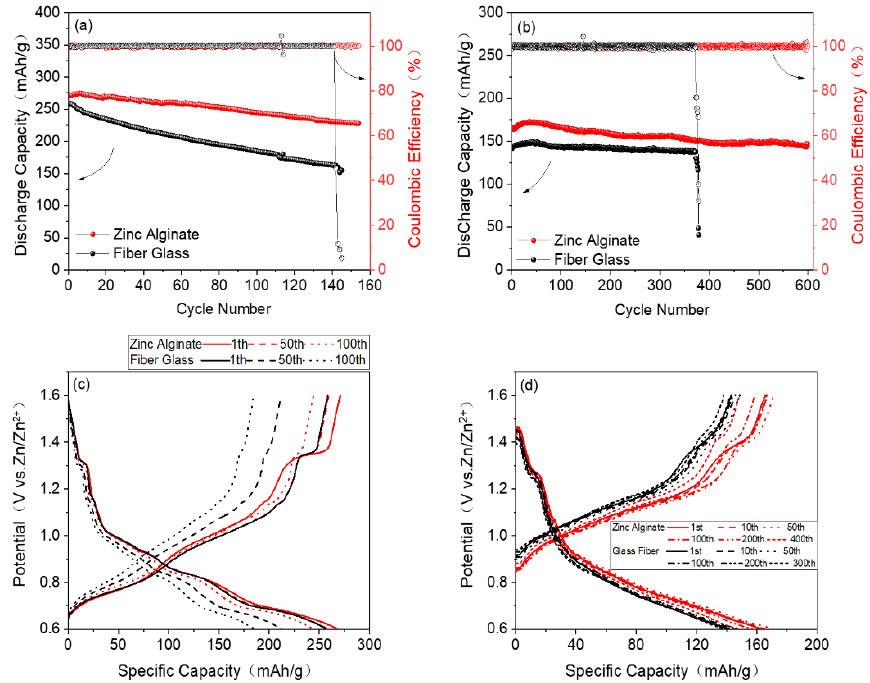
Figure 9. Electrochemical performance of the Zn/ZA-based HGPE/CVO and Zn/wet glass-fiber separator/CVO cells at room temperature: ( a ) 0.2 C and ( b ) 3 C. Charge and discharge curves of the Zn/ZA-based HGPE/CVO and Zn/wet glass-fiber separator/CVO cells at different cycles at ( c ) 0.2 C and ( d ) 3 C.